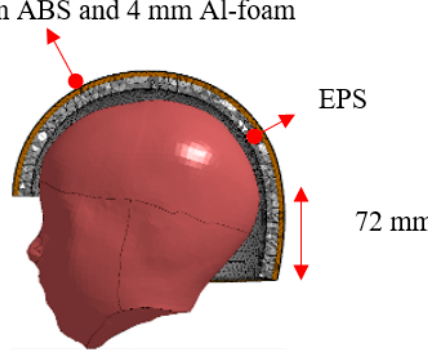
Figure 5. The modified child helmet with uniform liner thickness.